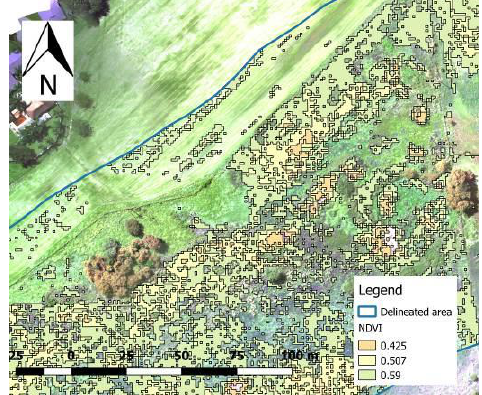
Figure 11. Intermediate NDVI values indicating wetland and grassland vegetation